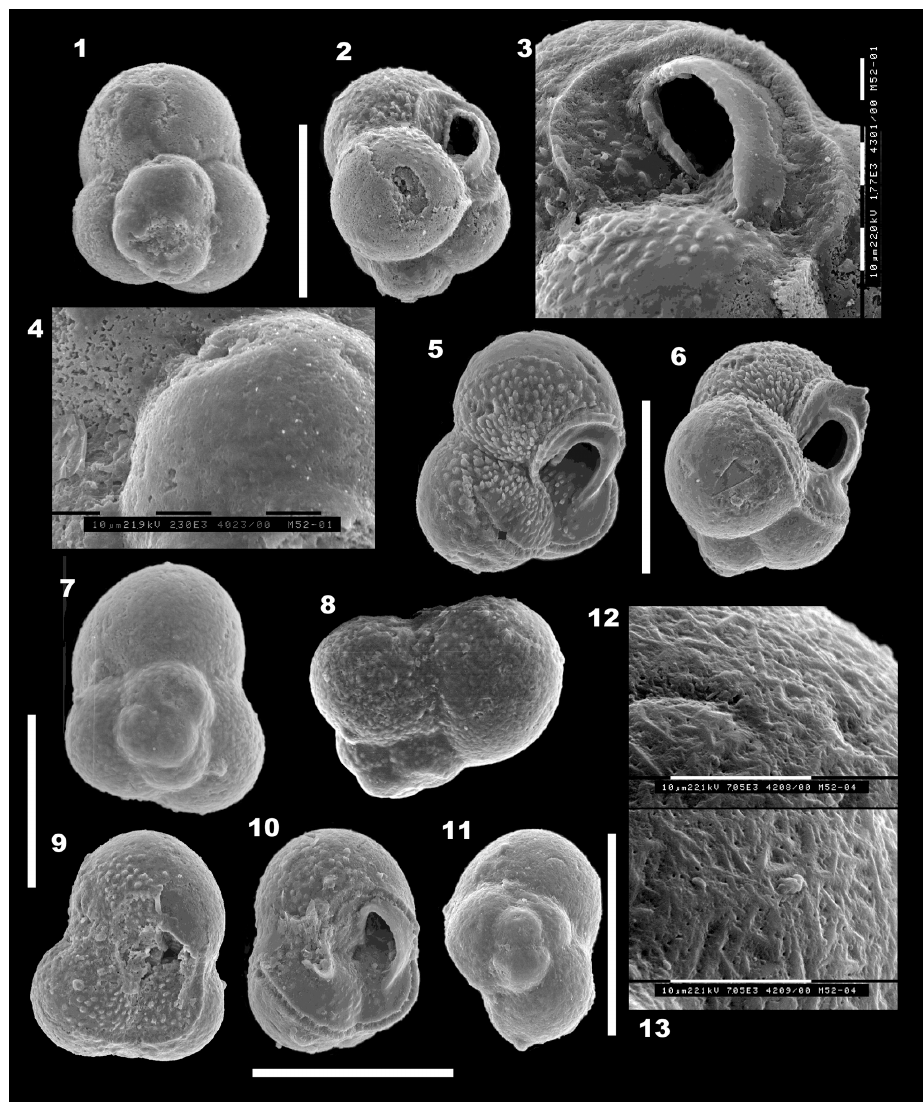
Figure 5. (1–13) Mermaidogerina loopae n. gen. n. sp. Scale bars are 100µm unless shown otherwise for individual figures. (1–4) Holotype WAM 18.22/M52-01; (1) spiral view; (2) side view; (3) detail of the asymmetrical loop-shaped aperture, turned to face the umbilicus, with the thickened lip on the peripheral margin extending forward into the broken final chamber. Each division of the scale bar is 10µm for (3) and (4) . (4) Detail of the smooth surface of the fourth chamber and part of the etched final chamber, as seen in (1) . (5–6) Paratype WAM 18.24/M51-03; (5) umbilical view of the triserial test, showing the broken final chamber at lower right and the scar of the thin-walled final bulla (at top and lower left), with tooth-like tubercules within the area of the bulla. (6) Side view, showing the asymmetrical loop of the aperture and smooth surface, lacking pseudomuricae, of the early chambers. The broken final chamber and the area covered by a thin-walled bulla are indicated by the faint scar of those walls. The prominent tubercules are virtually confined to the area in front of the aperture and within the final bulla. (7–9) Paratype WAM 18.23/M11-35; (7) spiral view showing porous surface with rare low pseudomuricae on the earlier chambers only. (8) Profile view, showing the raised, well-defined proloculus and initial whorl. (9) Umbilical view, with the final chamber or bulla broken off. Tubercules are well developed inside the broken chamber area. The aperture is damaged but part of the lip is visible. The scale bar at left is 100µm for (7) , (8) and (9) . (10–13) Paratype WAM 18.25/M52-04; (10) oblique umbilical–side view, showing shape of aperture, thick lip and broken final chamber. Note that the final aperture on the broken chamber was situated at the left side in an extraumbilical position. (11) Spiral (basal) view to show the proloculus and triserial coiling. The final chamber is broken away at lower left; it originally completed the second whorl. (12, 13) Two nearly contiguous areas on the surface of the second-last chamber (at upper right in 11 ). Note the “herring-bone” texture of interlocking triangular ridges, which are interspersed with pores. Note the absence of pseudomuricae on the porous wall. Scale bars on (12) and (13) : 10µm; original magnification is 7050 × . All specimens are from sample BMR